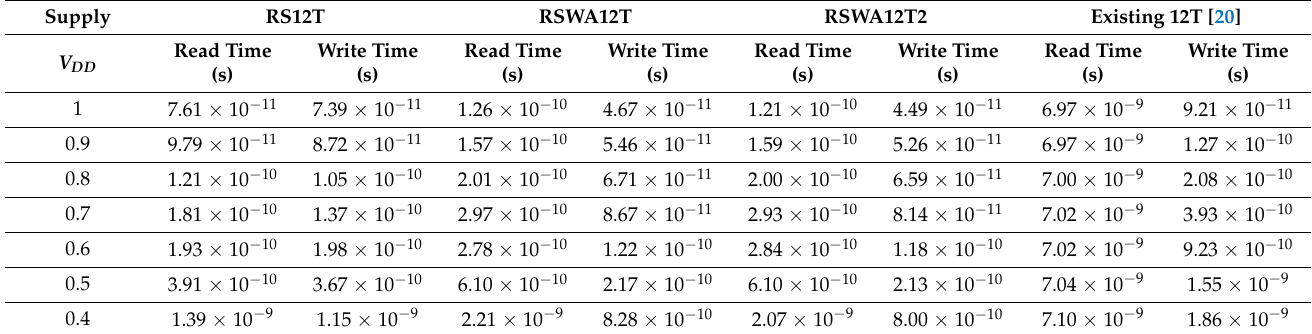
Table 2. Comparative performance analysis for 128 bit length array.